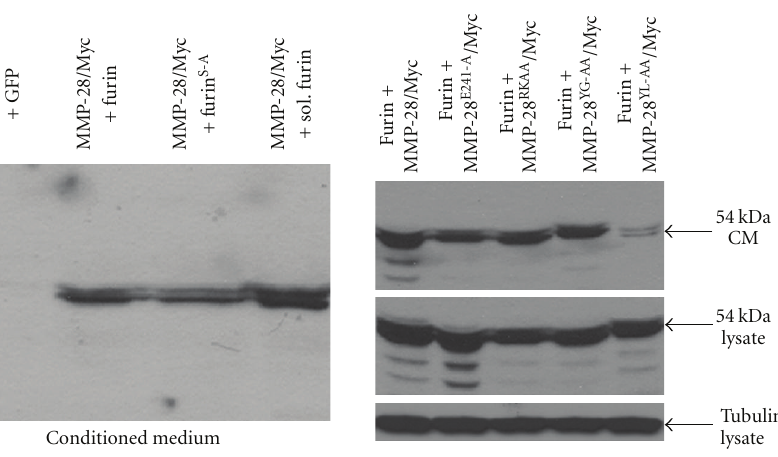
Figure 2: Enhanced secretion of MMP-28 by co-transfection of COS-1 cells with furin cDNA. The data show that MMP-28 secretion requires coexpression with furin. Furin does not increase newly synthesized MMP-28. Instead, Furin promotes existing MMP-28 secretion from storage pools to secretory pathway. Active state of furin is not